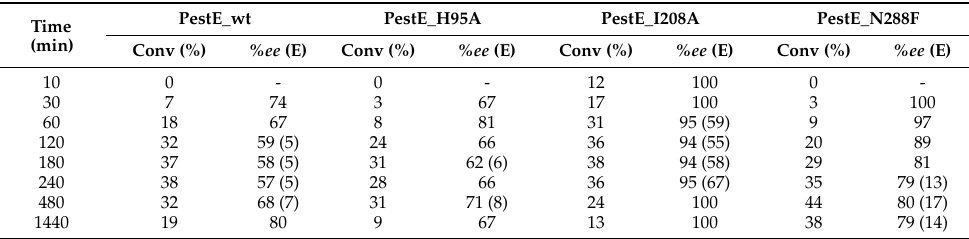
Table 1. Menthyl acetate conversion and product enantiomeric excess from transesterification reactions catalyzed by PestE wild type and mutants.